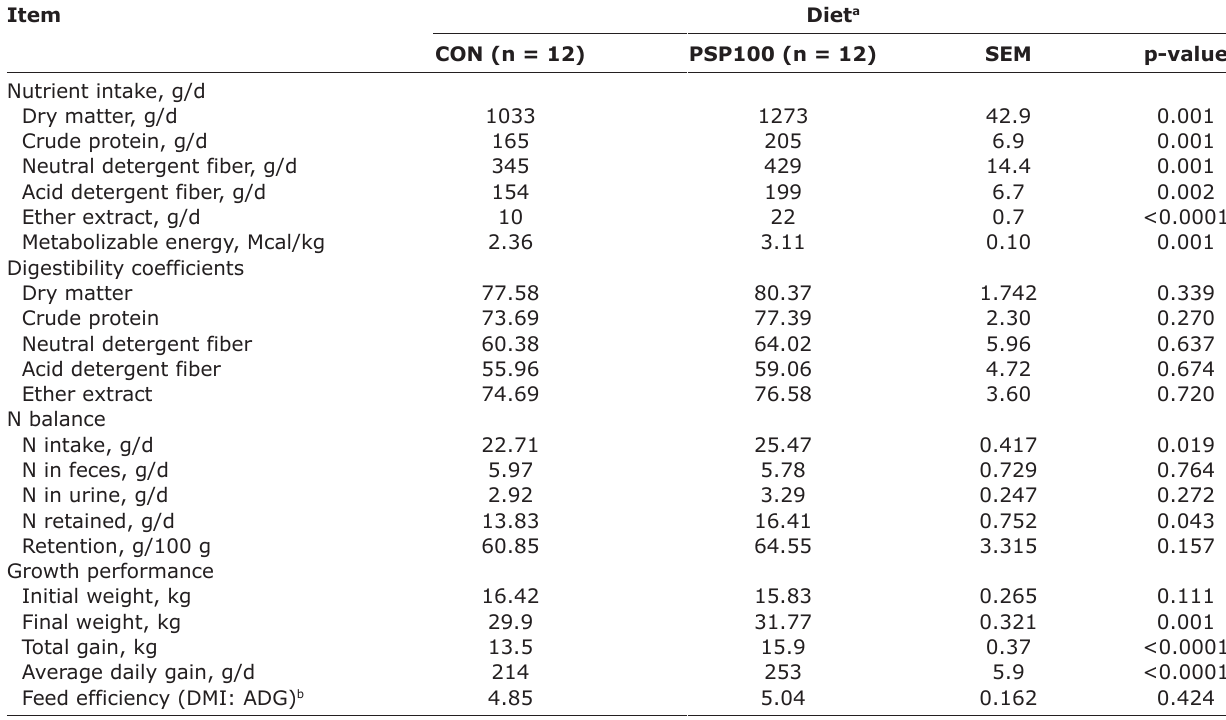
Table-2: Effects of feeding PSP on nutrient intakes, digestibility, N balance, and growth performance of Awassi lambs.